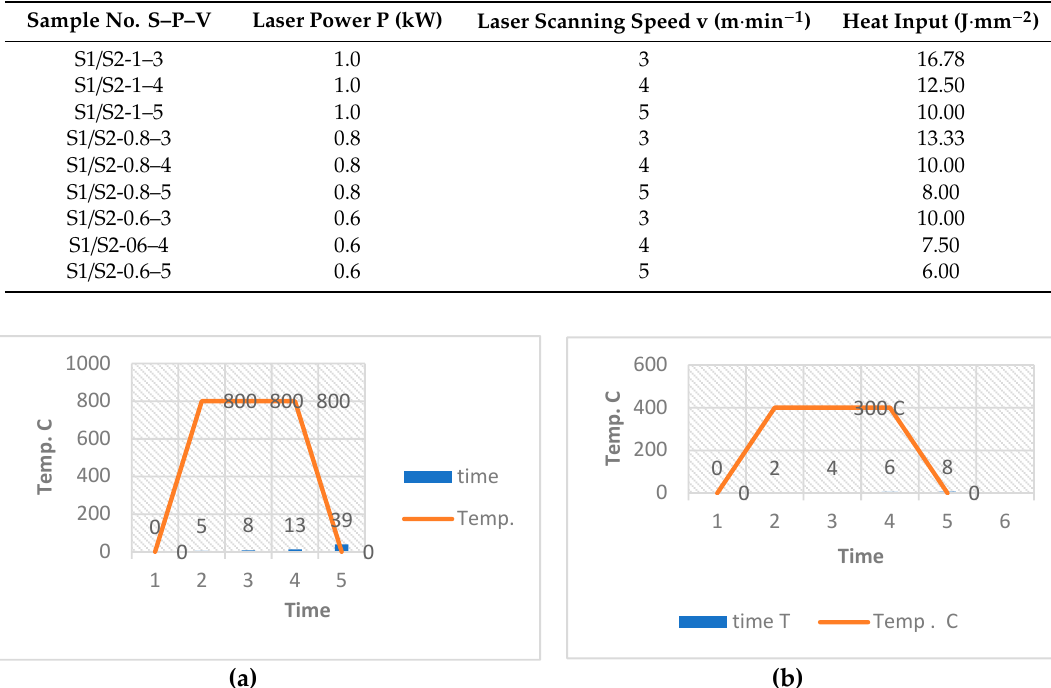
Table 2. The laser surface treatment parameters.